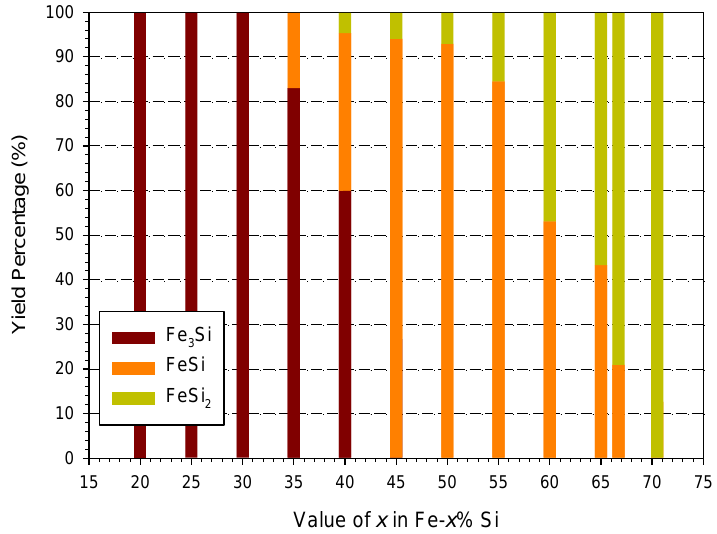
Figure 6. Yield percentages of iron silicides (Fe 3 Si, FeSi, and FeSi 2 ) from samples with different Si percentages in Fe- x % Si.